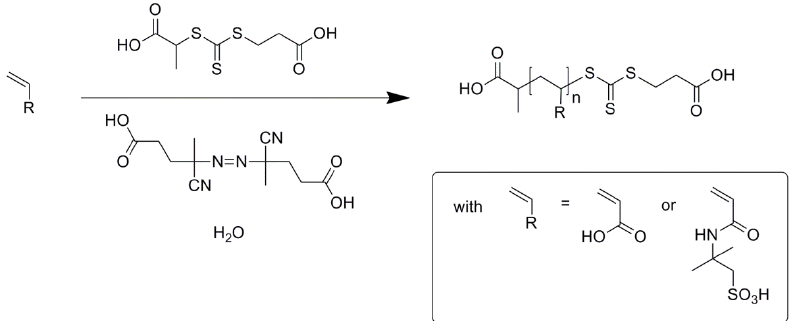
Scheme 1. RAFT polymerization of water-soluble monomers acrylic acid (AAc) and